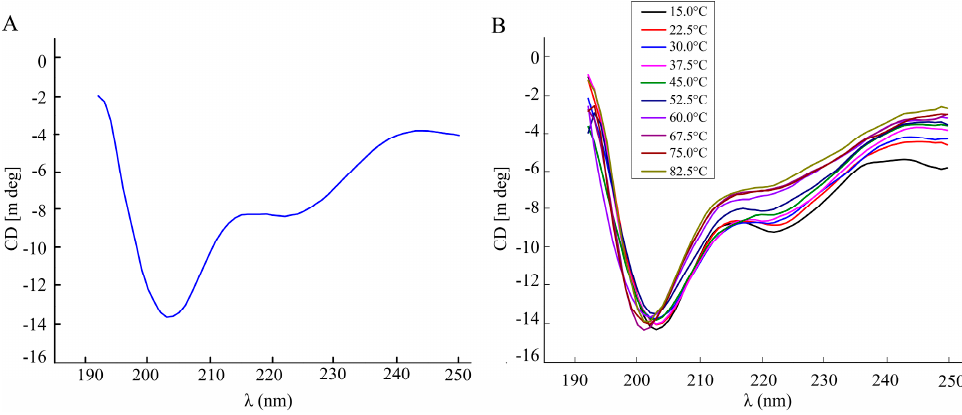
Figure 3. The secondary structure and thermal stability analysis of BmGlv2. ( A ) Circular dichroism spectrum of BmGlv2. ( B ) The secondary conformational profiles of BmGlv2 in the range of 15 to 82.5 °C.